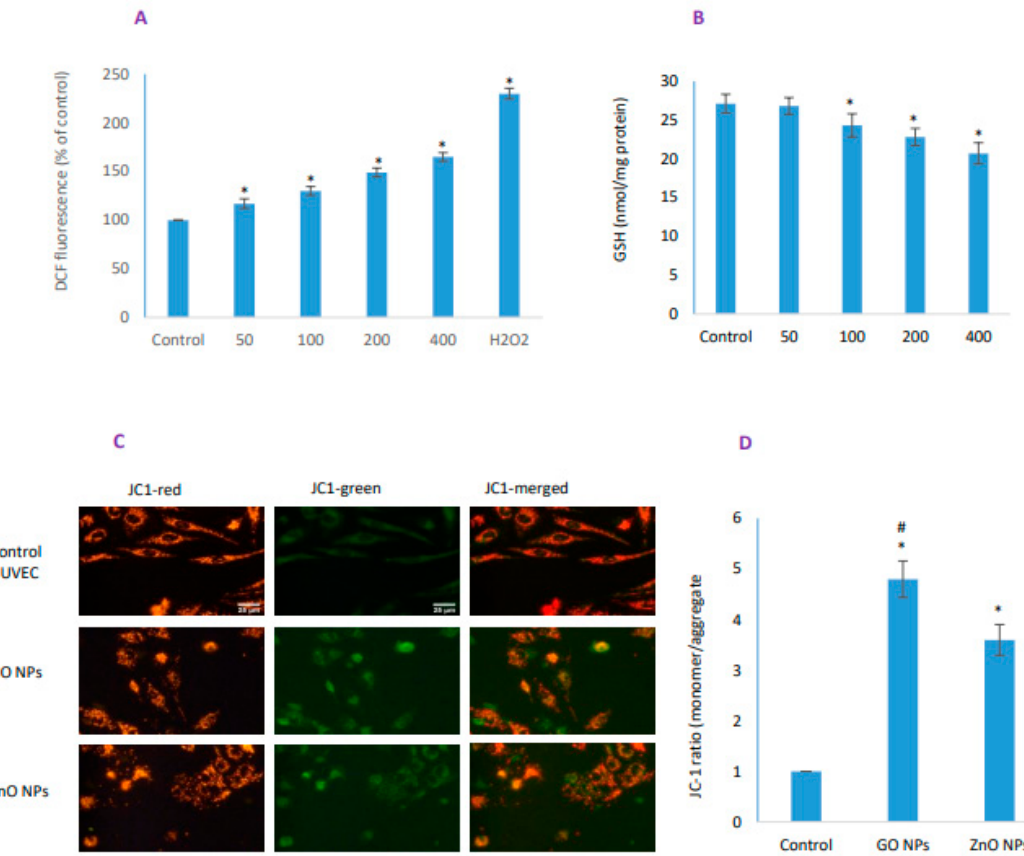
Figure 4. Level of oxidative stress was determined by measuring ( A ) reactive oxygen species (ROS) induction and ( B ) GSH depletion in HUVEC cells. H 2 O 2 was used as a positive control of oxidant in DCFH-DA probing. MMP was detected by JC-1 in control and treated groups of HUVECs; ( C ) images captured in tandem for JC-1 monomer (green) and JC-1 aggregate (red); ( D ) Quantification of MMP is given as ratio of monomer/aggregate. Scale bar represents 25 µm in each image (40× objective). * Statistically significant difference than the controls ( p < 0.05). #—Significantly high MMP induction due to GO NPs compared to ZnO NPs ( p < 0.05).